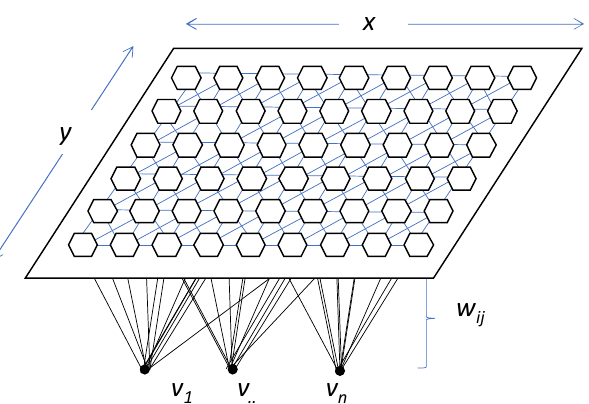
Figure 6. General example of SOM model’s topography. Dimensions are expressed by x and y ; v 1–n represent each one of the input neurons, and w ij is the weight of each vector according to Kohonen’s notation.